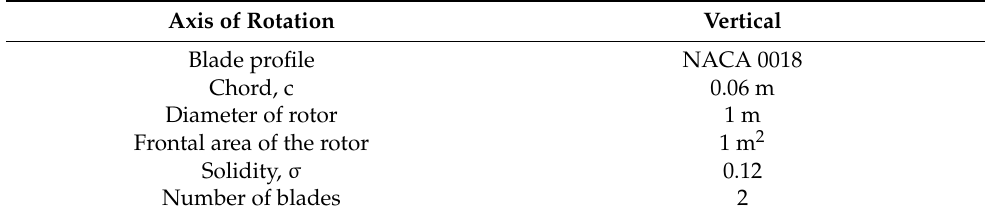
Table 1. Geometric features of the turbine considered for the study.